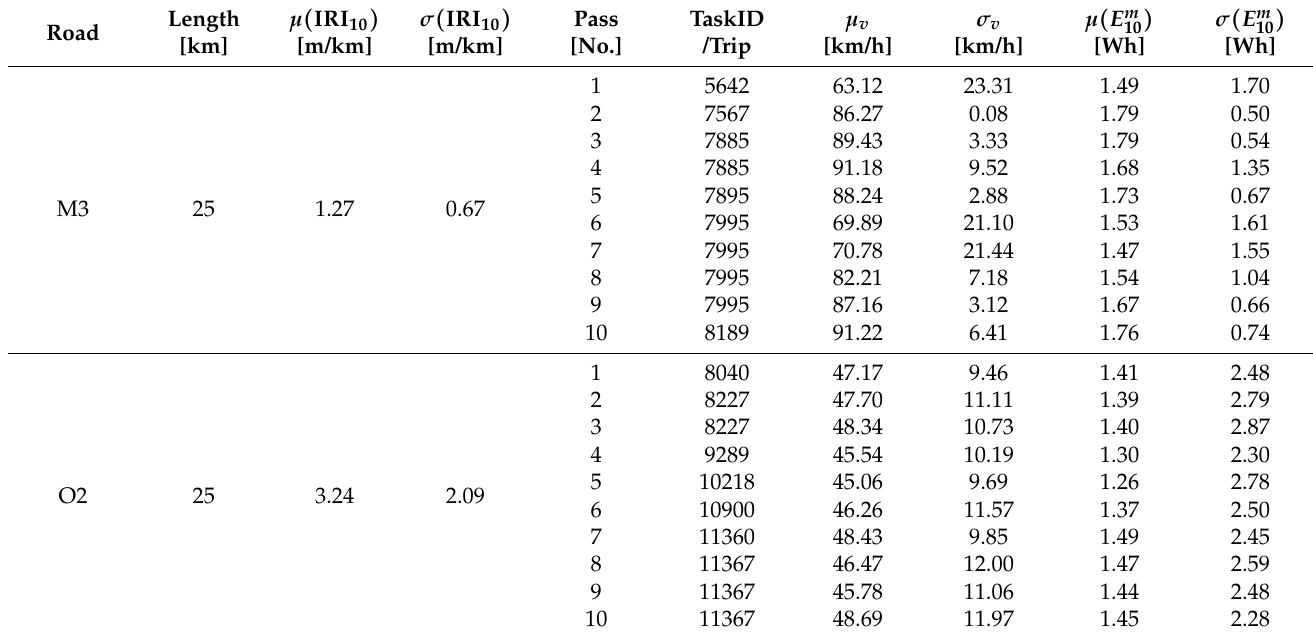
Table 6. Overview of selected roads employed for demonstration of the road energy efficiency monitoring